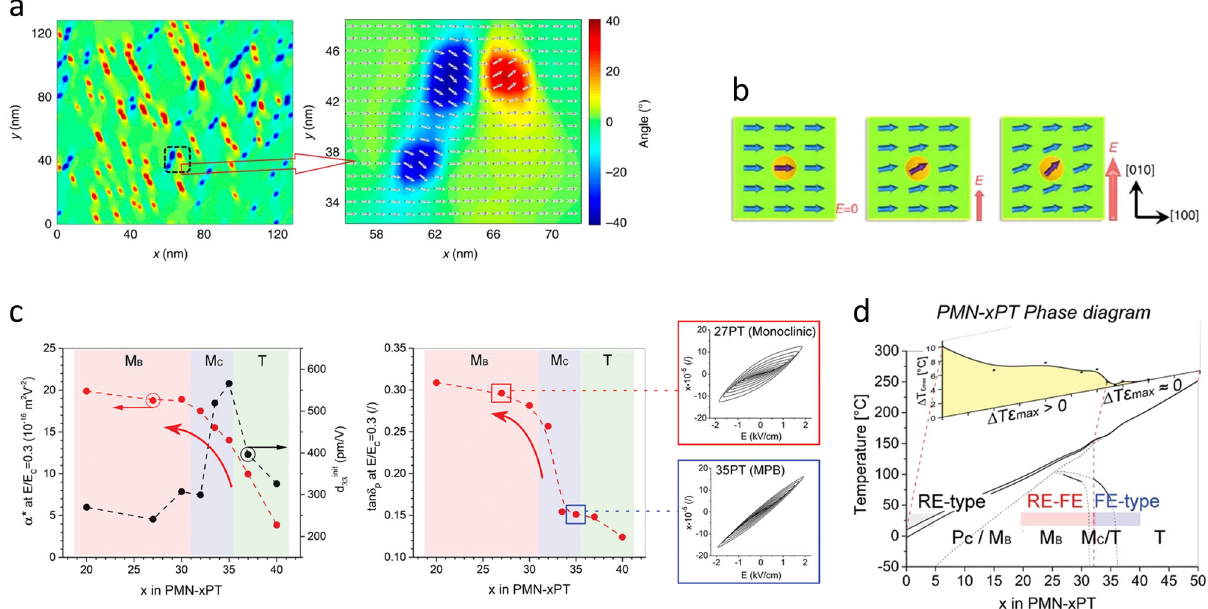
Fig. 3 Proposed mechanisms for the large piezoelectric response of PMN – PT single crystals and ceramics. a Phase- fi eld simulated polar state at 100 K of a composite consisting of [100]-poled FE matrix (green) and inclusions of PNRs (red, yellow and blue). The x-and y-axes denote [100] and [010] direction, respectively, with the colors represent the direction of the local polarization. The right-hand inset shows an enlarged region highlighting the nano- sized PNRs with the different direction of polarization (different symmetry) with respect to that of the matrix FE phase. b Proposed mechanism of enhanced piezoelectric response of lead-based RE-FEs based on the polar state shown in ( a ). Green area and blue arrows represent the FE matrix and the associated polarization (P s ), respectively; yellow circles and purple arrows represent PNRs and their local polarization, respectively. The schematic shows the initial state at room temperature under no applied electric fi eld E (left), where PNRs and P s are nearly collinear, and under an applied E perpendicularly to the spontaneous polarization (P s ) of the FE matrix (middle and right schematic). The large piezoelectric response is explained by the rotation of PNRs along the E direction, which helps rotating the spontaneous polarization of the nearby FE region (details are reported in Ref. 14 ). c Reversible (d 33 init ) and irreversible ( α * ) Rayleigh coef fi cients, and phase angle (tan δ p ) of PMN – PT ceramics as a function of PT content extracted from the fi eld dependence of the converse piezoelectric response. The different colors mark the individual phase regions (M B and M C stand for monoclinic and T for tetragonal). The insets show piezoelectric hysteresis loops (displayed for increasing fi eld amplitudes) representative of M B (top) and MPB (bottom) composition. d Phase diagram of PMN – PT denoting the different types of nonlinear responses in the RE (gray), RE-FE (red) and FE (blue) regions of the PMN – PT system identi fi ed based on distinct third-harmonic responses (for details see Ref. 36 ). The inset shows the frequency dispersion of the temperature-dependent maximum of the dielectric permittivity ( Δ T ε max ) as a function of PT content. The connecting line denotes the compositional point (~32 mol% PT) of the transition between the RE-FE-type and FE-type response coinciding with the drop of Δ T ε max to dielectric nonlinear response (denoted in Fig. 3d as RE-, RE-FE- and FE-type). The pronounced hysteretic and nonlinear response of PMN-richer M B composition showing RE behavior (see red- box inset of Fig. 3c) was contrasted with the more common RE behavior is not observed (see blue-box inset of Fig. 3c). The